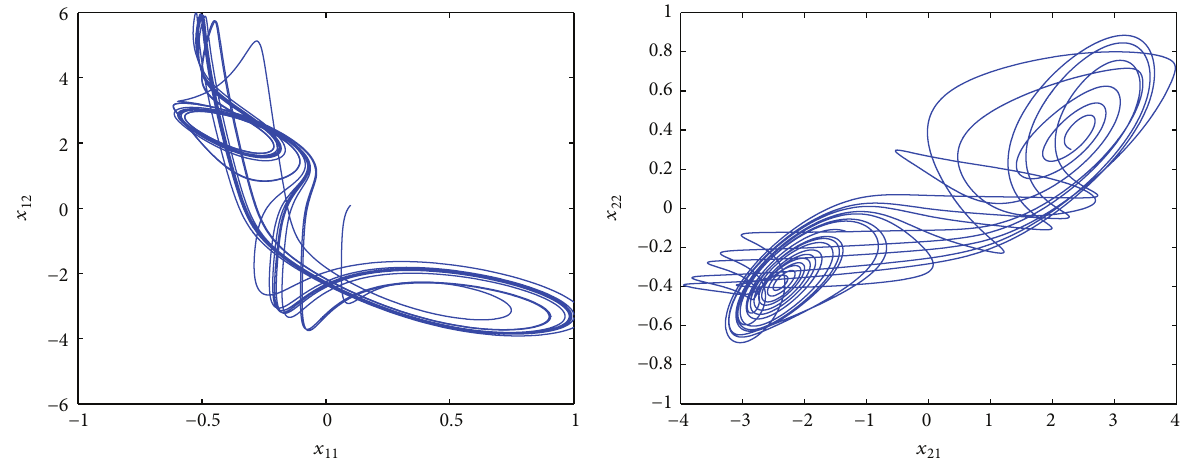
Figure 1: Chaotic attractor of two subsystems of switched networks.